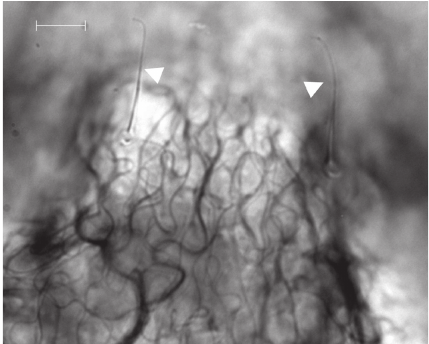
Figure 2: O. ovis L1 surface (630x). White arrows indicate cuticular sensilla and white bar indicates 10 𝜇 m length.